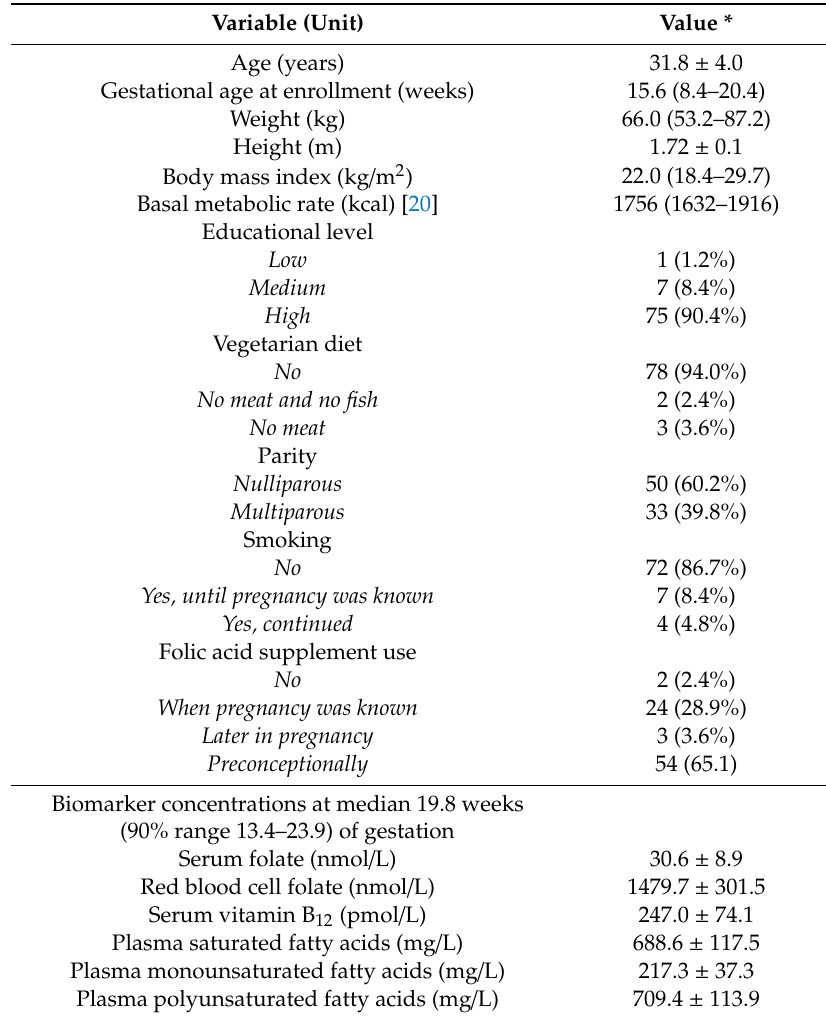
Table 1. Participant